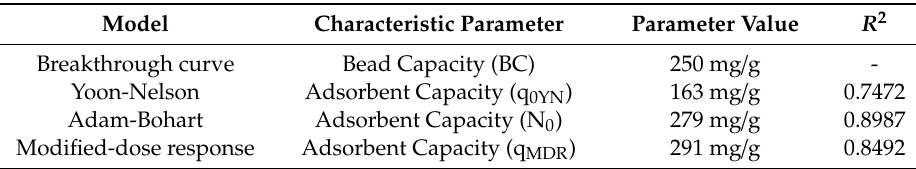
Table 3. Column study—Adsorption modeling.